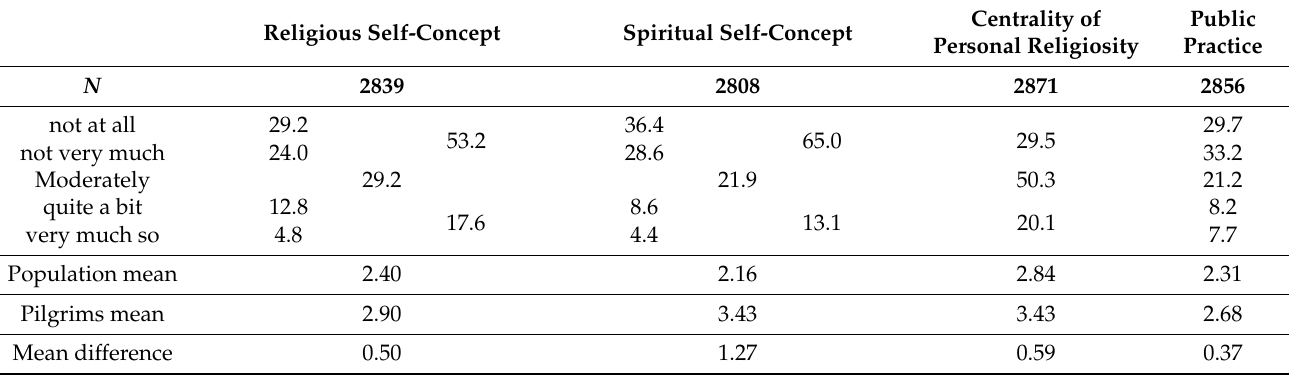
Table 7. Percentage distribution of responses and mean values on religious and spiritual self-concept and the centrality of personal religiosity and public religious practice in the normal population in Germany, Austria, and Switzerland (weighted data).